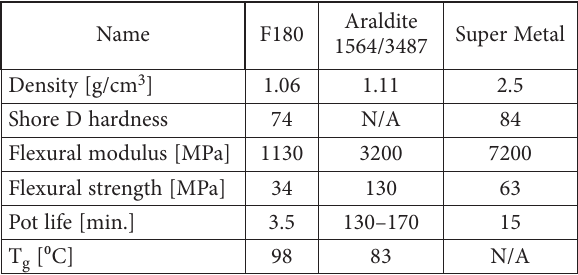
Table 1. Basic mechanical and thermal properties of tested